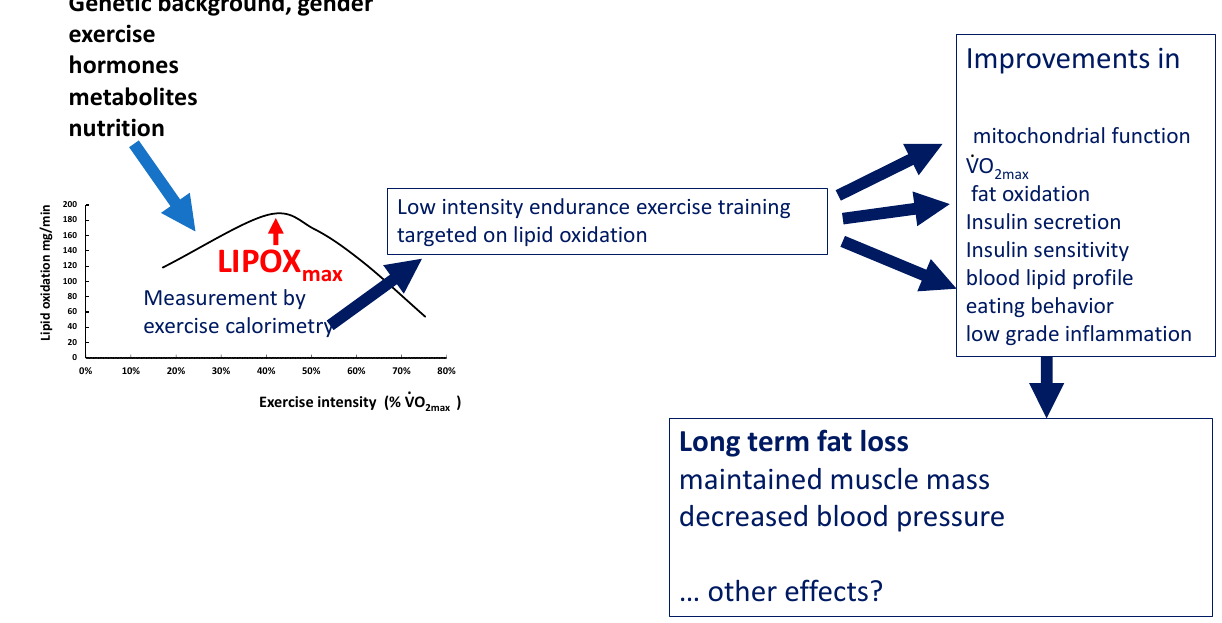
Figure 10. Summary picture. Maximal oxidation during exercise is determined by genetic background and gender, as well as hormones (catecholamines, GH, estradiol), exercise habits, and nutrition. It is a rather stable and reproducible parameter, unless subjects change their lifestyle, and is impaired in various pathologic conditions (obesity, diabetes, sleep apnea, bariatric surgery). This level or others closely related can be used for targeting exercise training. There is now good evidence that in the middle term (2–6 months), this variety of exercise training improves mitochondrial function, VO 2max , lipid oxidation during exercise, parameters of glucose disposal, LDL cholesterol, and low-grade inflammation. Fat mass decreases and fat-free mass are maintained. In diabetics, the decrease in HbA 1c elicited by this variety of training is of the same magnitude as that of other protocols ( − 0.6%). In fact, the effects on VO 2max , blood pressure, and circulating levels of lipids at 2–6 months are less pronounced than those of higher-intensity protocols and interval training. A moderating effect on sedentarity-associated overeating is also reported by several studies and occurs over the first week. Long-term effects are only reported by a limited number of nonrandomized studies but they appear to be prolonged (up to 7 years), inducing a gradual improvement in body composition (loss of central and limb fat mass, maintenance of muscle mass) and blood pressure. Whether such prolonged training can have other beneficial effects is not yet known. More studies are needed to better describe and understand all these processes.